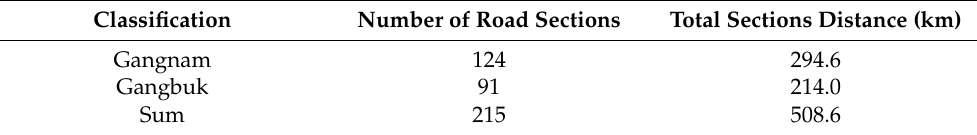
Table 6. Numbers of road sections and their total distance for different Seoul districts. Classification